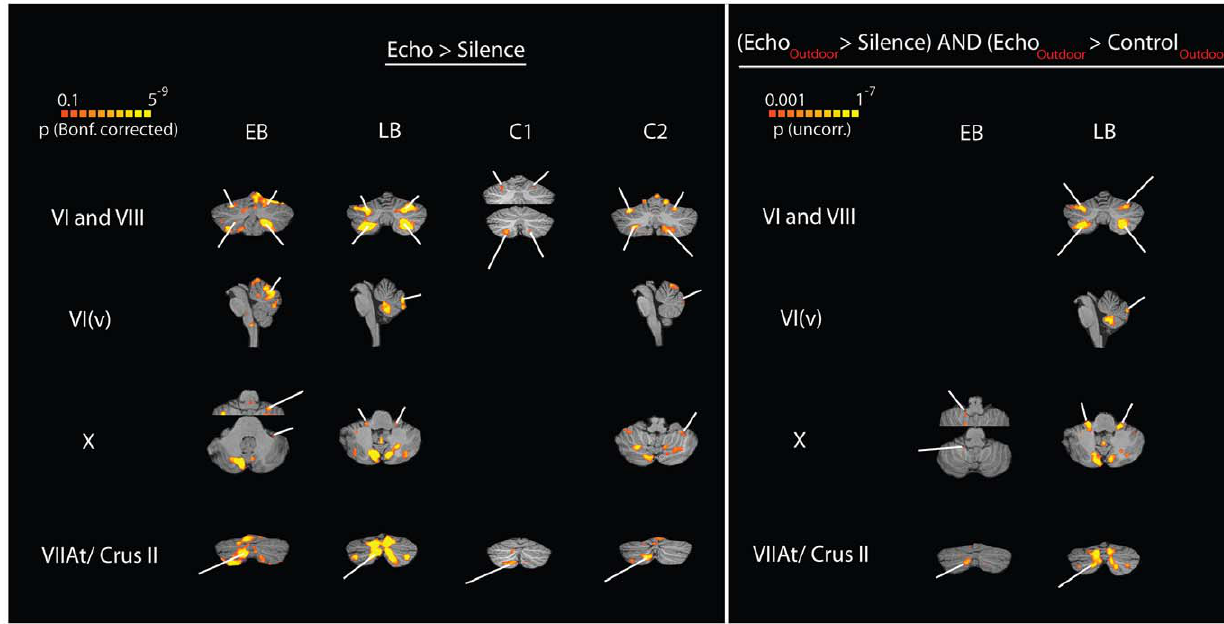
Figure 6. BOLD activity in the cerebellum. Data are shown in neurological convention, i.e. left is left. Activity in the cerebellum was analyzed in stereotaxic space [49]. To evaluate significance of activity we used the same voxelwise significance thresholds as for cortical surface analyses for each participant. However, because the number of voxels in volume space differed from the number of vertices in surface space for each participant, the Bonferroni corrected significance level differs between cortex and cerebellum (compare Figure 2). To increase accuracy, cerebellar structures for each participant were identified based on anatomical landmarks. Structures were labeled according to the nomenclature developed by [26]. Left panel: BOLD activity while participants listened to recordings of echolocation sounds that had been made in an anechoic chamber and judged the location (left vs. right), shape (concave vs. flat) or stability (moving vs. stationary) of the sound reflecting surface (see Figure 1F for behavioral results). Right Panel: Contrast between BOLD activations for recordings containing echoes from objects and recordings that did not contain such echoes. Data are not shown if no significant activity was found (empty cells in table).